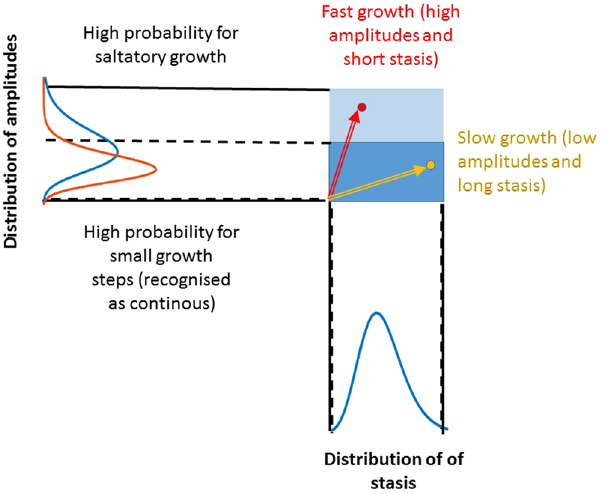
Figure 2. Schematic of the growth process modelled by the time-varying biased random walk. The distribution of stasis times is shown on the x axis by the blue lognormal curve. Two distributions of growth increment amplitudes are shown by the lognormal curves on the y axis. The blue represents a faster growth with larger increments at an younger age while the brown demonstrates a later stage of growth with smaller increments. For the stasis time, only one curve is shown as experiments do not suggest that this distribution changes with age. On this diagram, the red vector represents fast growth with short stasis time and large increments whereas the yellow vector corresponds to slow